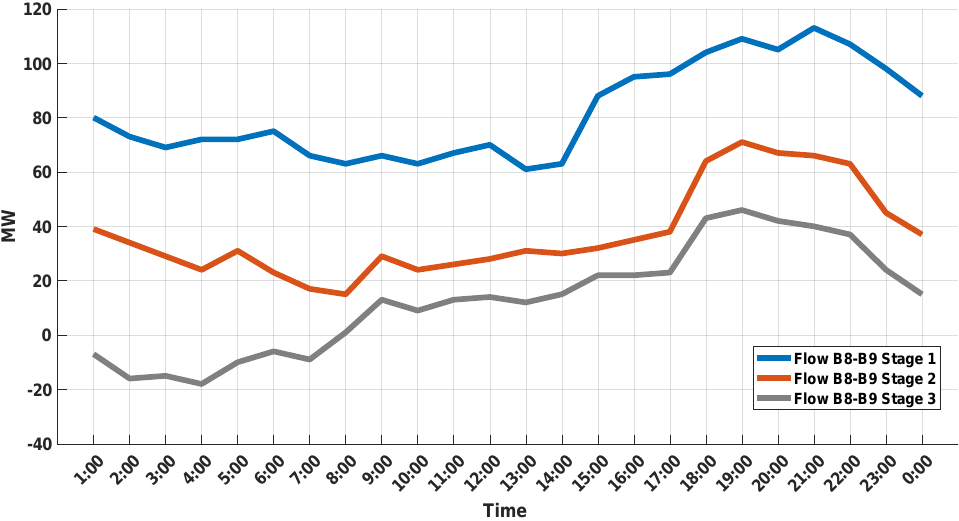
Figure 32. Power flow variation from bus 8 to bus 9